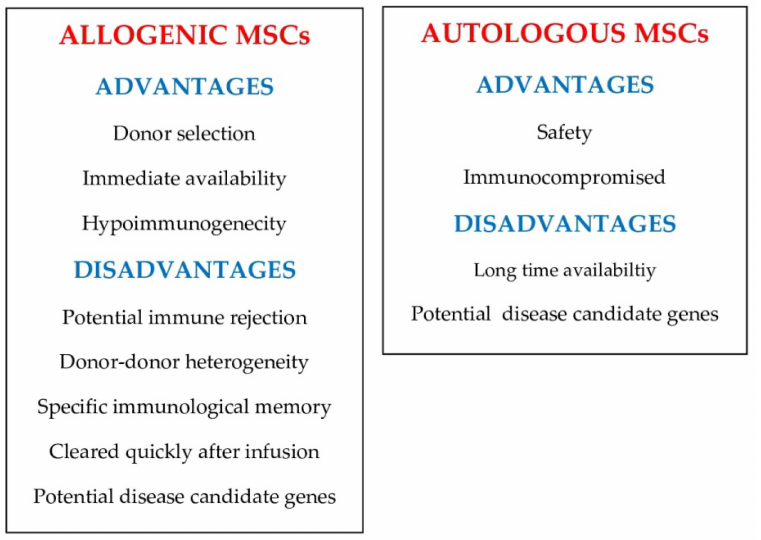
Figure 3. Pros and cons of allogenic and autologous mesecnchymal stem cells